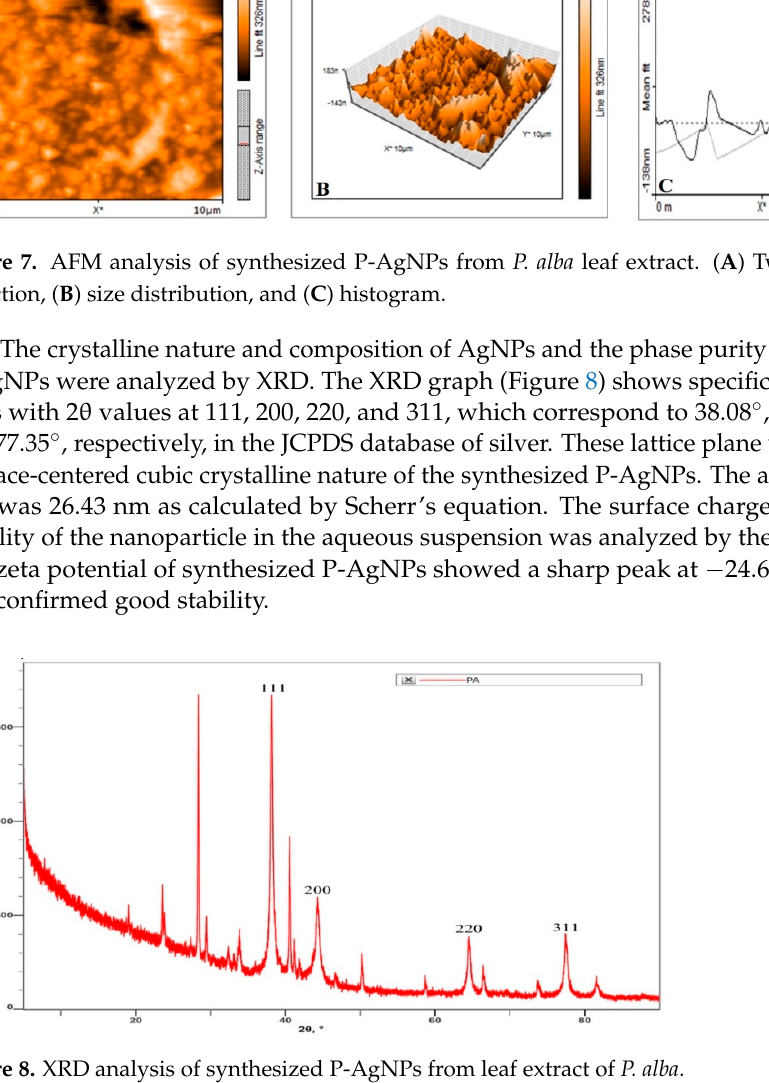
Figure 6. TEM Analysis of Synthesized P-AgNPs from P.alba leaf extract. ( A ) Polydispersed AgNPs, ( B ) Single spherical-shaped AgNP and ( C ) P-AgNPs’ histogram showing size distribution.